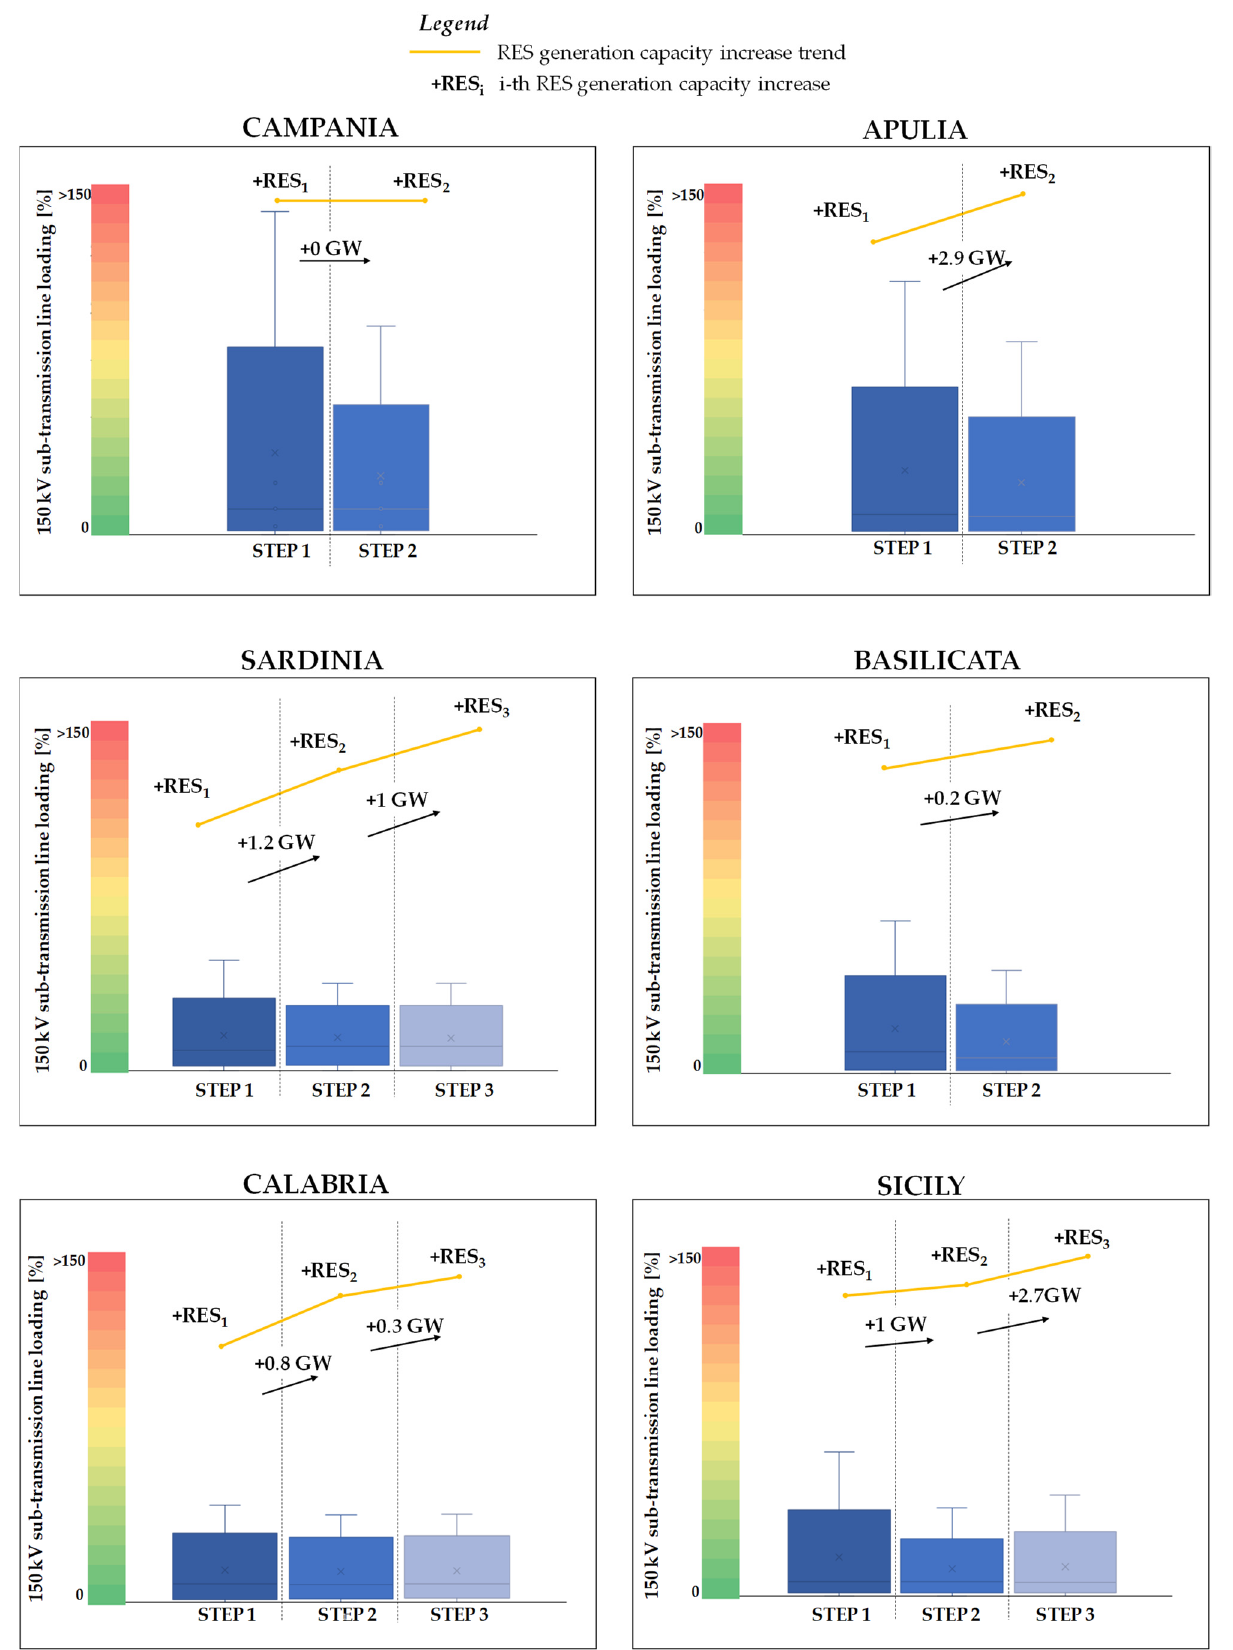
Figure 12. Boxplots summarising the HV subtransmission line loading (%) in different RES increase steps in Italian regions under consideration.